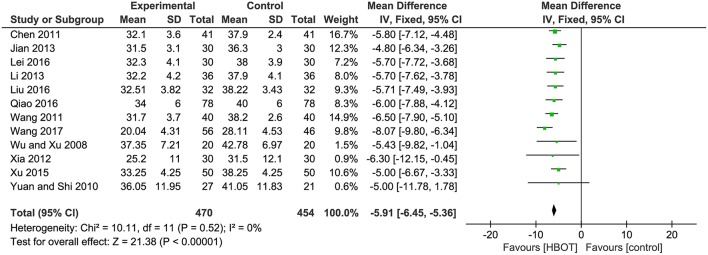
Comparison of the ADL score after treatment between the HBOT group and the control group.